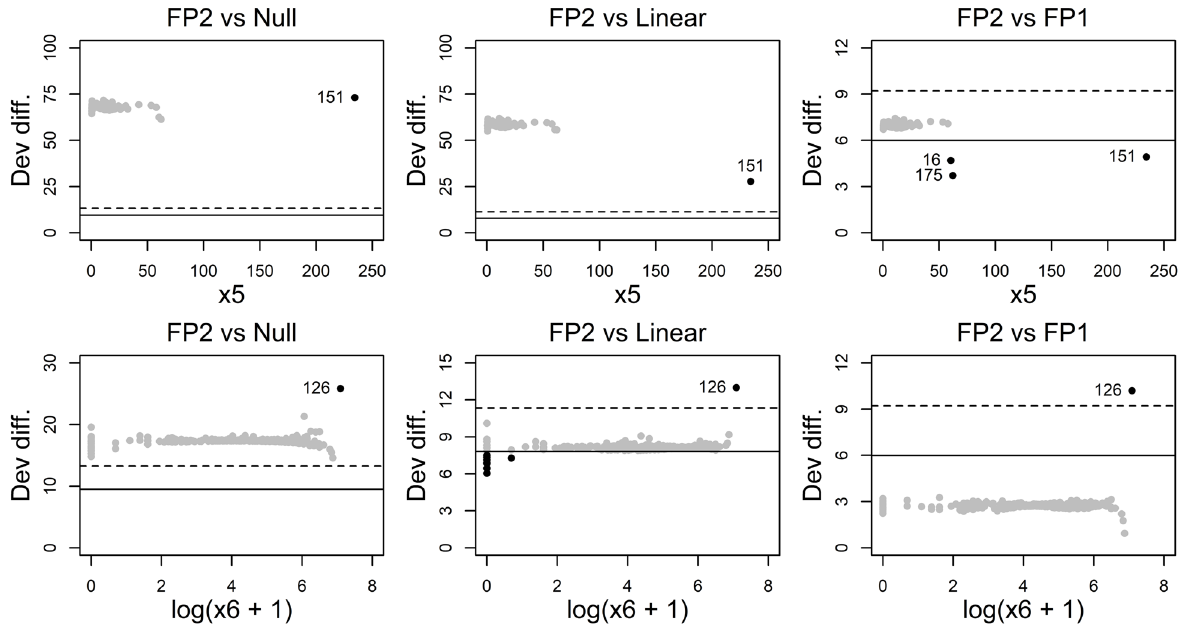
Fig. 2 Data A250. Plots of deviance differences for each model comparison against observed values for variables x5 and x6. A logarithm scale was used for variable x6 to ease visualization due to extremely large values. Please note that y -axis scales differ. Two threshold values, representing the significance levels α 0.05 and α 0.01, are shown on the plots as horizontal solid and dashed lines, respectively. Please note that the test of FP2 vs = = linear and FP2 vs FP1 may not be relevant if the test of FP2 vs Null is not significant. Nevertheless, we will always show the full